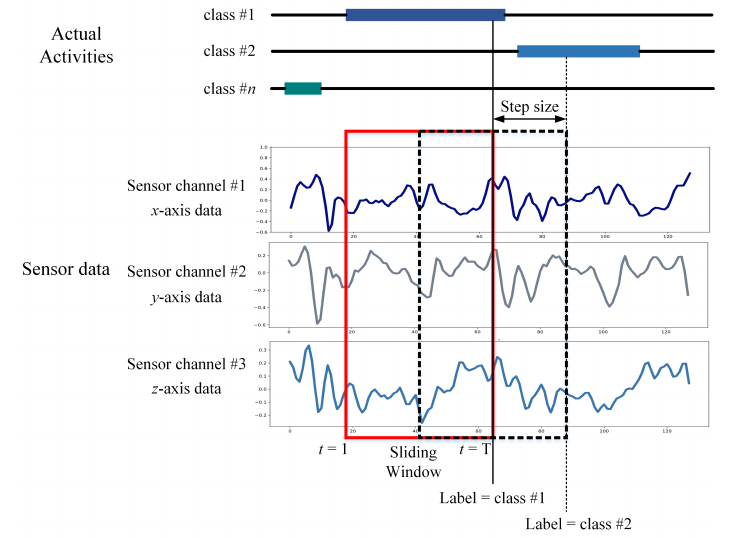
Figure 2. Data segmentation by the OW scheme.